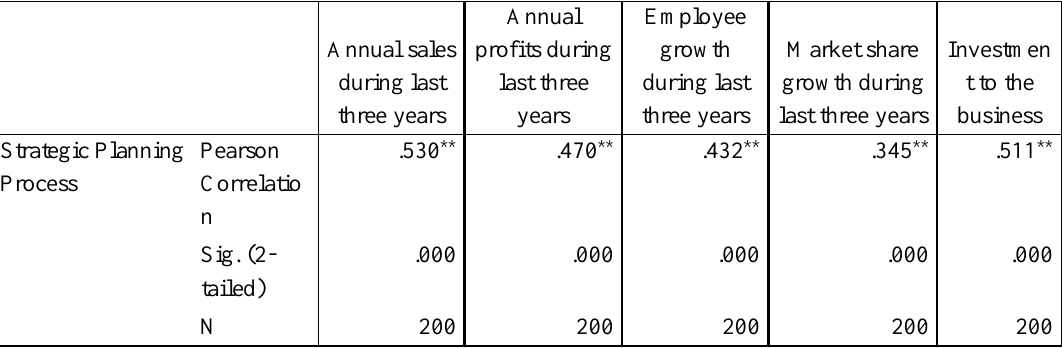
Employee profits during during last last three during last years three years last three years